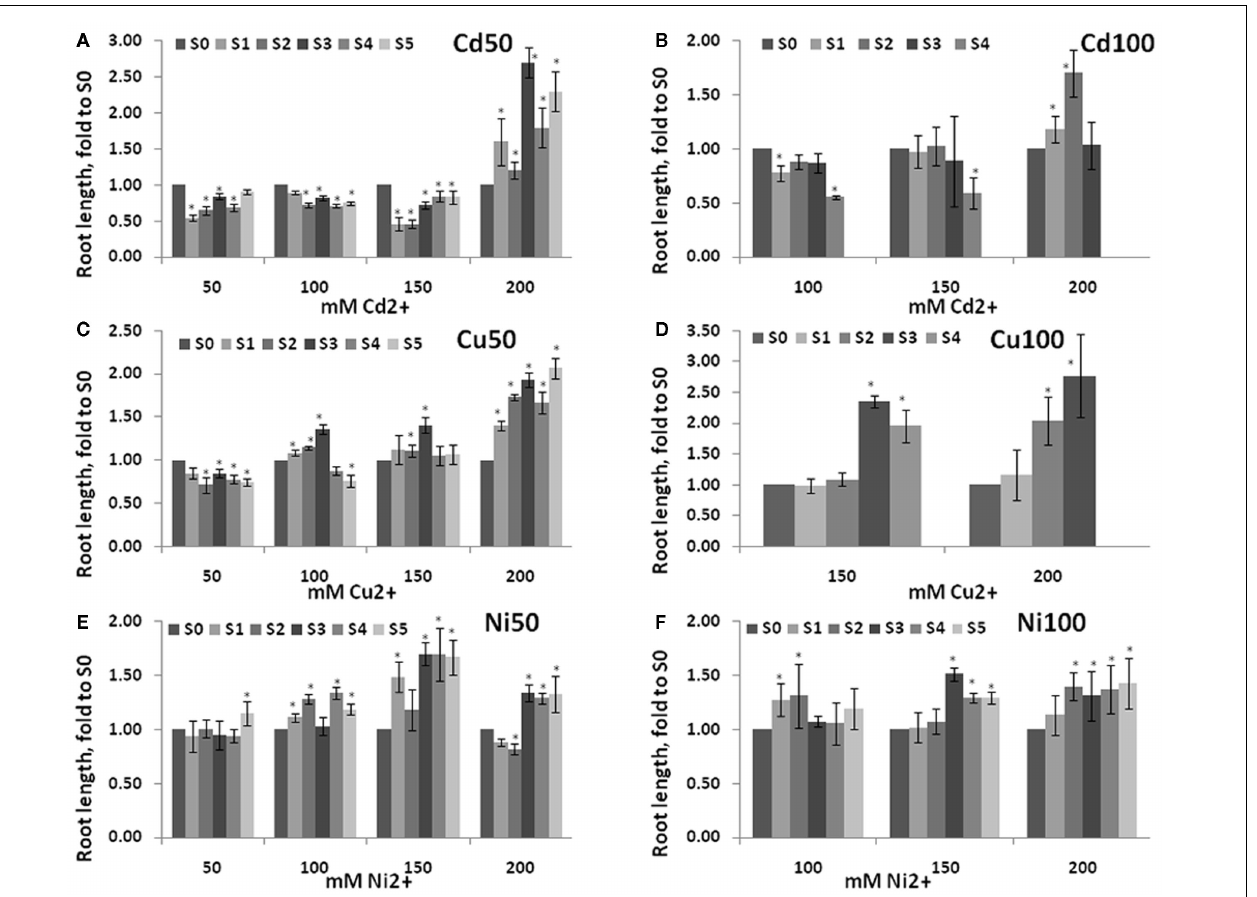
FIGURE 5 | Root length in the progeny of stressed plants exposed to high concentration of heavy metals. Root length was measured in five consecutive generations of non-exposed plants and plants exposed to 50mM Cd 2 + (A) , 100mM Cd 2 + (B) , 50mM Cu 2 + (C) , 100mM Cu 2 + (D) , 50 Ni 2 + (E) , and 100mM Ni 2 + (F) . Plants were germinated and grown on MS medium supplemented with 50, 100, 150, and 200mM of respective heavy metal salt,